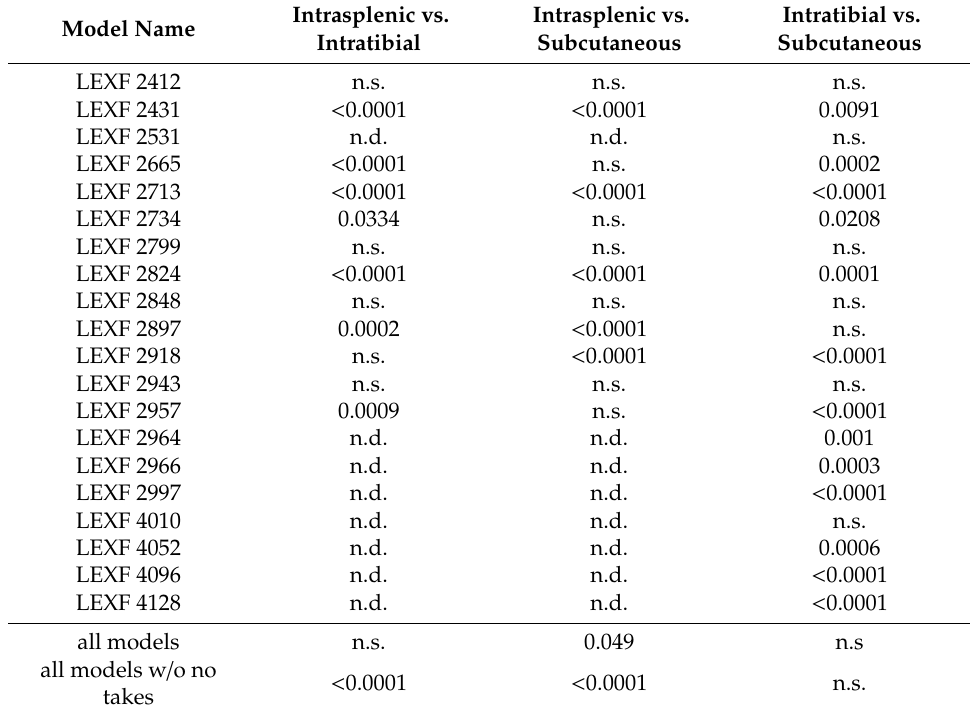
Table 2. Comparison of overall survival (OS) times within one model depending on the implantation route (Log-rank (Mantel–Cox) test). Intrasplenic vs. Intrasplenic Model Name